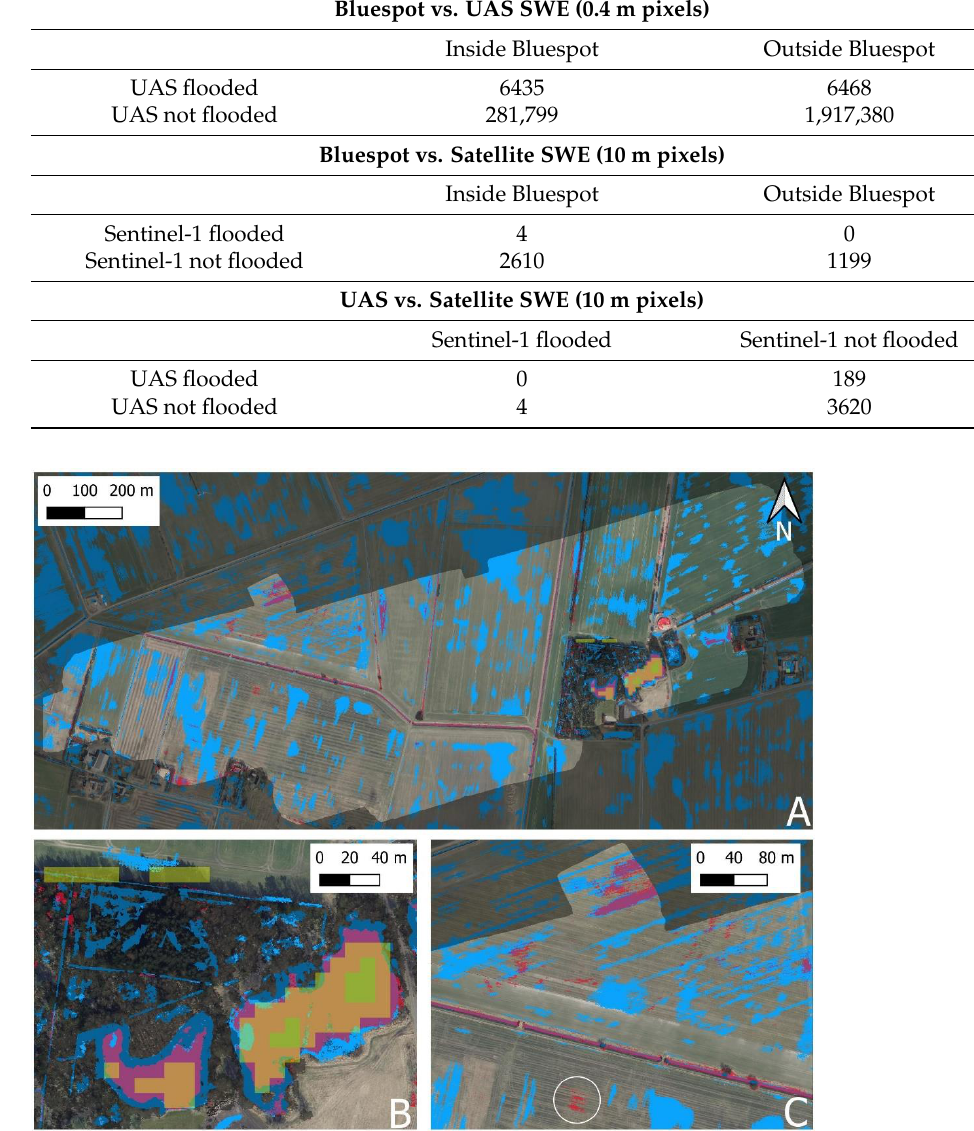
Table 1. Contingency table for the Rødehus Kanal area. We only report contingency tables for Sentinel-1 SWE because the only pixel mapped as flooded by Sentinel-2 is located outside the thermal scene.